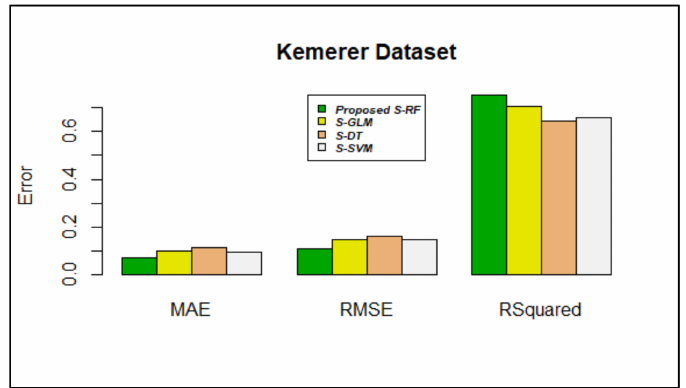
Figure 6. Error rate vs. stacking models in the Kemerer dataset.